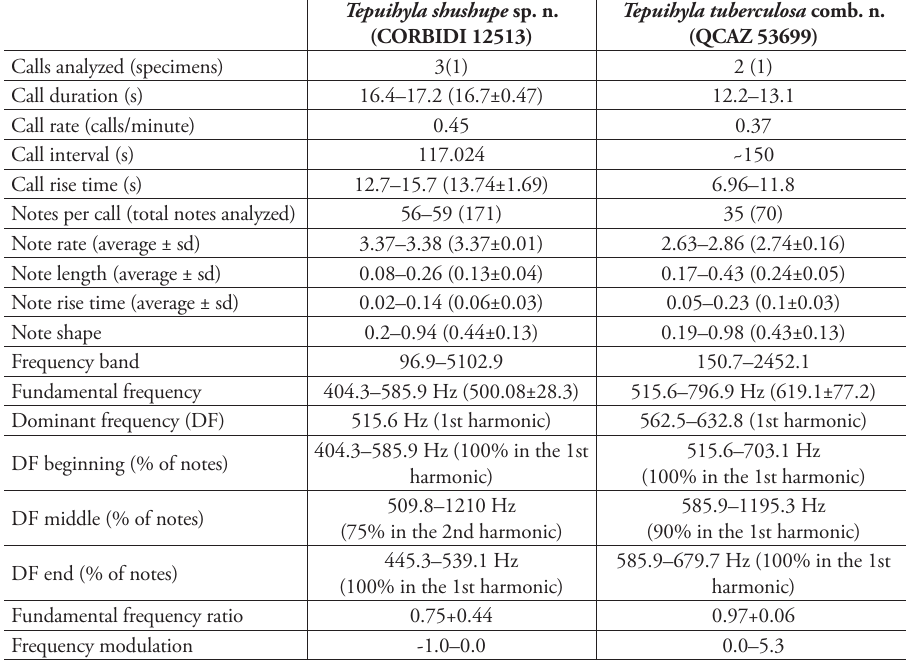
Table 3. Quantitative and qualitative characteristics of the advertisement call of Tepuihyla from Ecuador and Peru. The recording in Peru was made in the Loreto Department, Putumayo River basin, Rio Ere on 18 October 2012, air temperature of 21.3 C. The recording in Ecuador was made in Pastaza Province, Juyuintza on 22 June 2012, air temperature 23.9